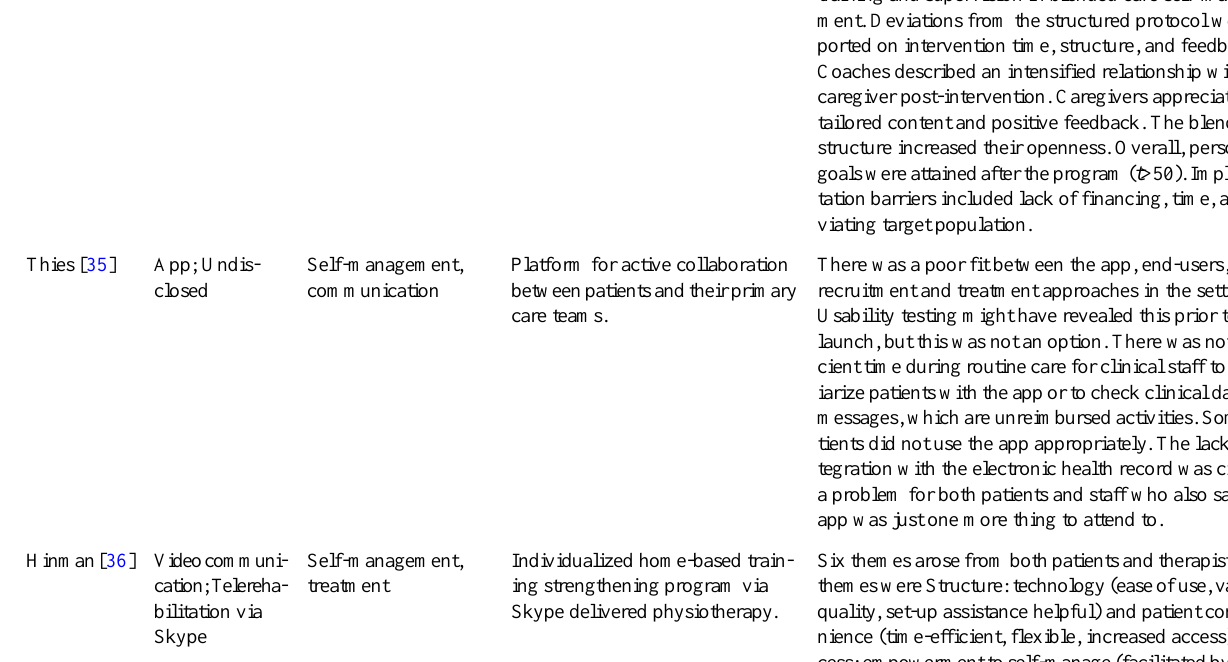
Study results (findings) a InterventioneHealth functionTechnology; in-